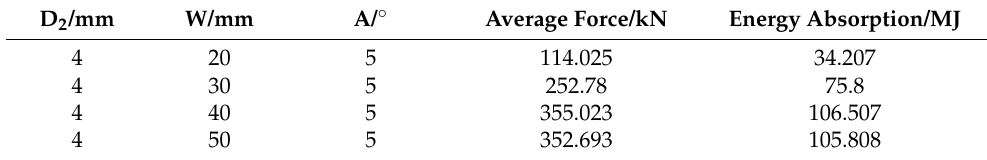
Table 4. Influence of W on material properties.